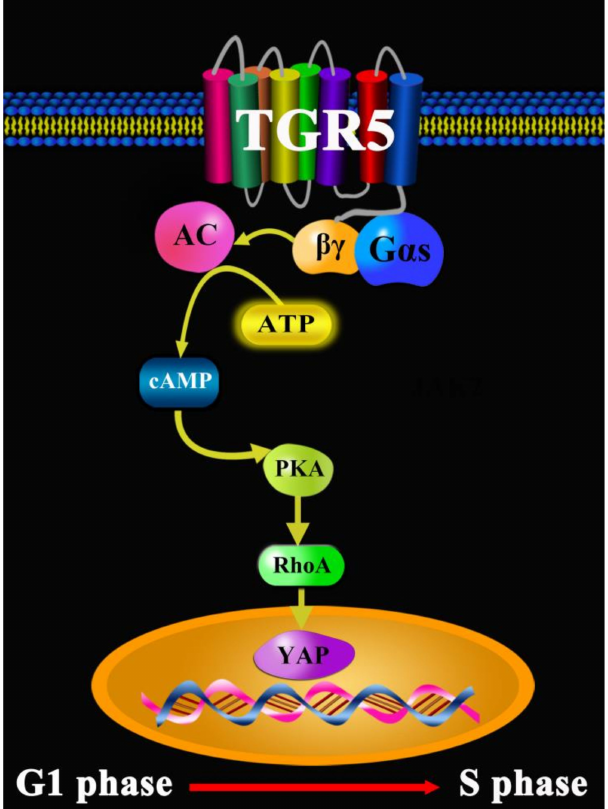
Figure 6. TGR5 in colorectal